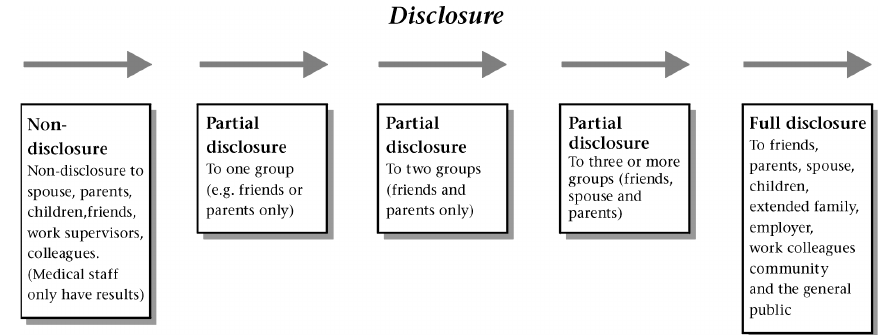
Figure 2: Path of